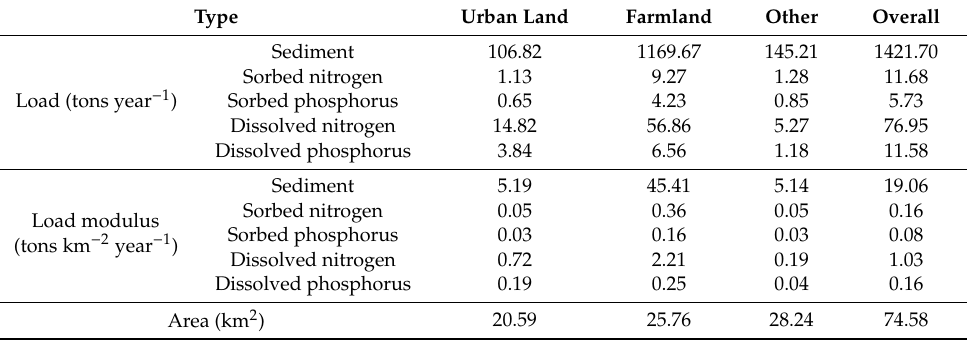
Table 6. Annual average simulation results of NPS pollution production from the period 2000–2018.